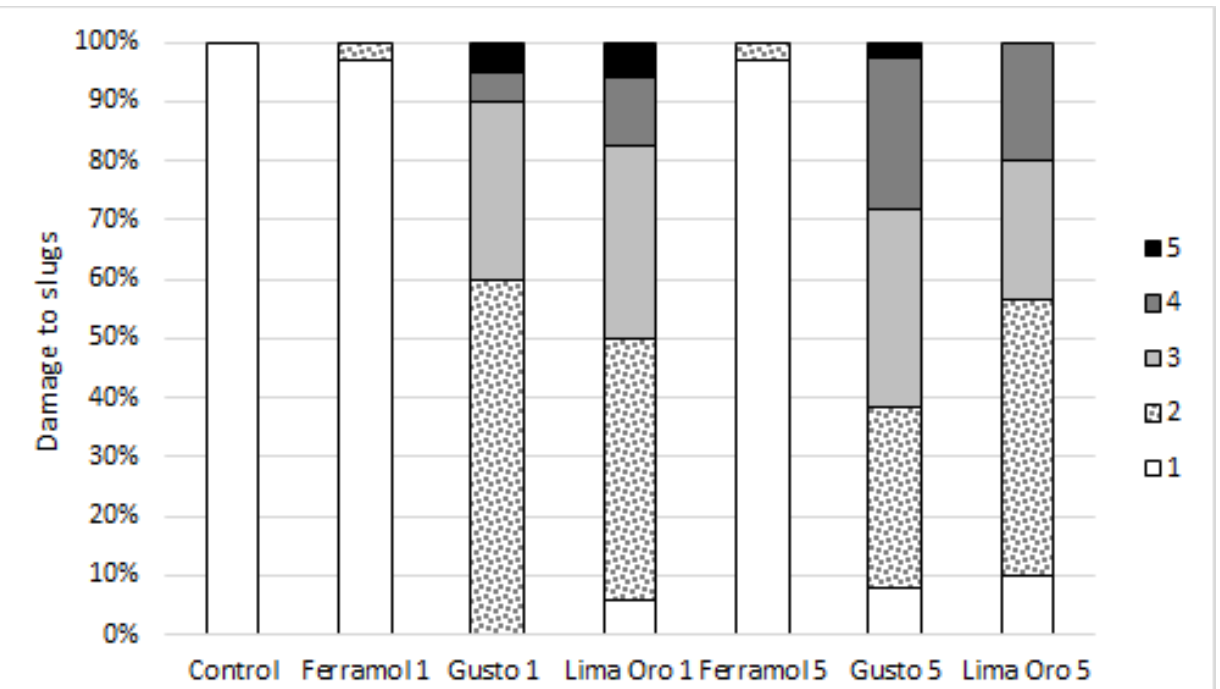
Figure 2. Percentage of damage to slugs ( n = 320) by molluscicides, expressed in each damage cate- gory: 1 — no visible damage; 2 — body has some mucus; 3 — body has excessive yellow slime secre- tions; 4 — body has excessive orange slime secretions and some body deformation (raised tail, genital protrusion, or other); 5 — dead. The number next to the molluscicide name on the x-axis indicates the number of pellets (1 or 5) for each treatment.